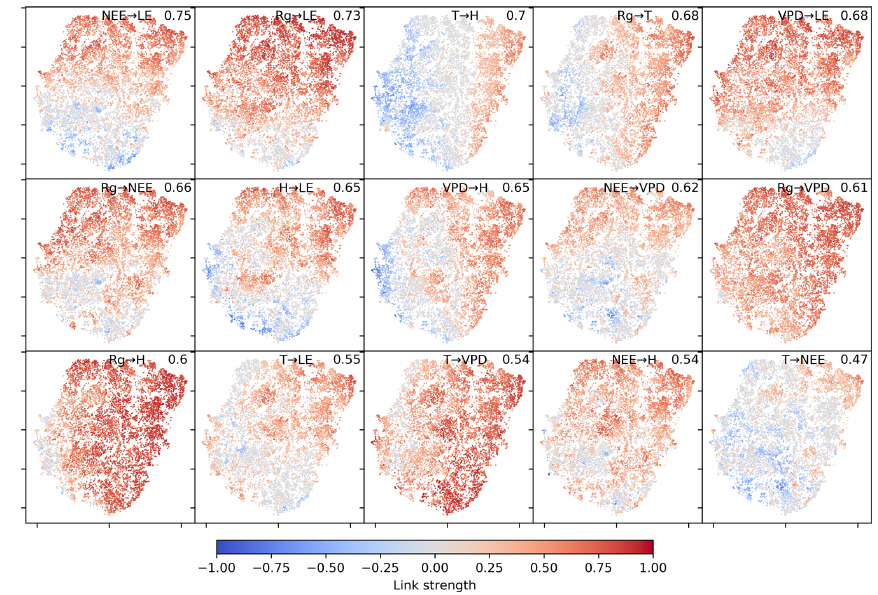
Figure B4. Same as Fig. 2 but produced from a new run of the analysis which does allow influences on R g . The orientation of data points in this plot has changed compared to Fig. 2 due to the stochastic nature of t -SNE. But the embedding is almost merely mirrored.